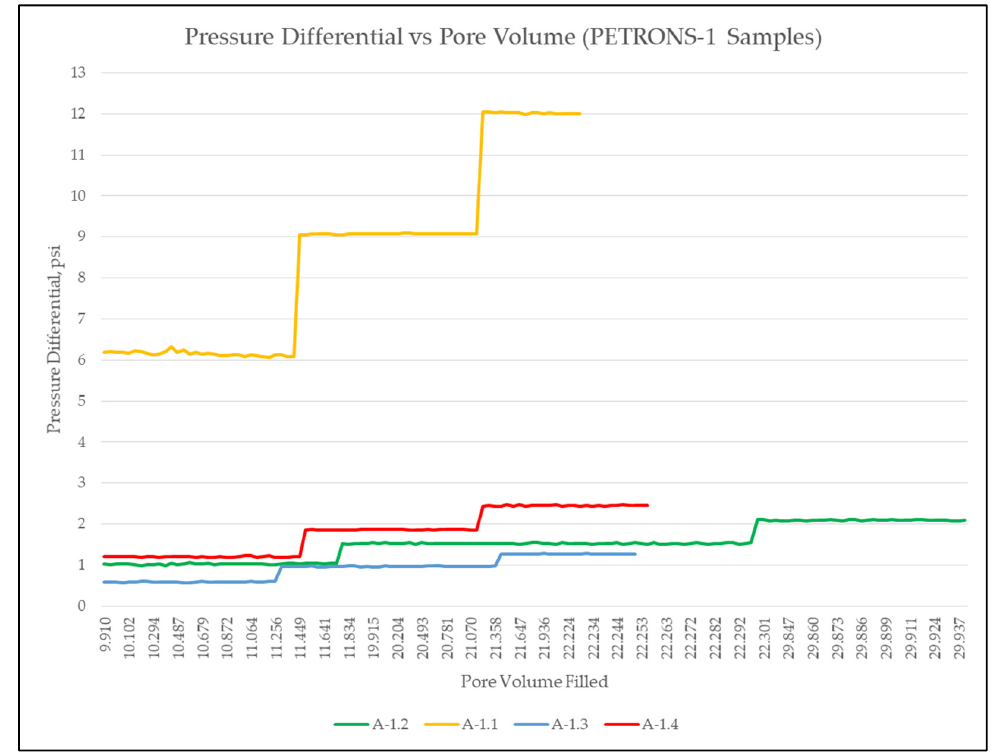
Figure 10. Graph of pressure differential against pore volume filled for PETRONS-1 samples.